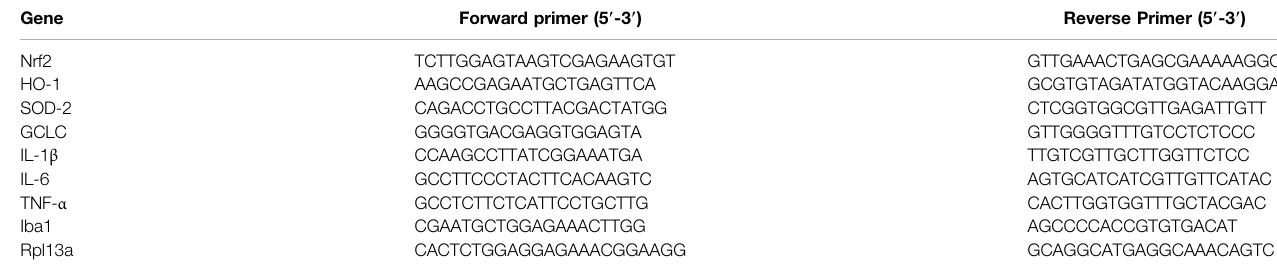
TABLE 1 | Primer sequences.